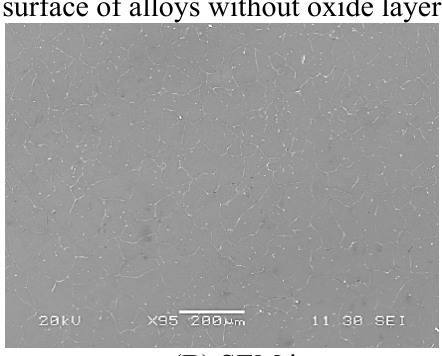
( C ) backscatter image ( D ) backscatter image